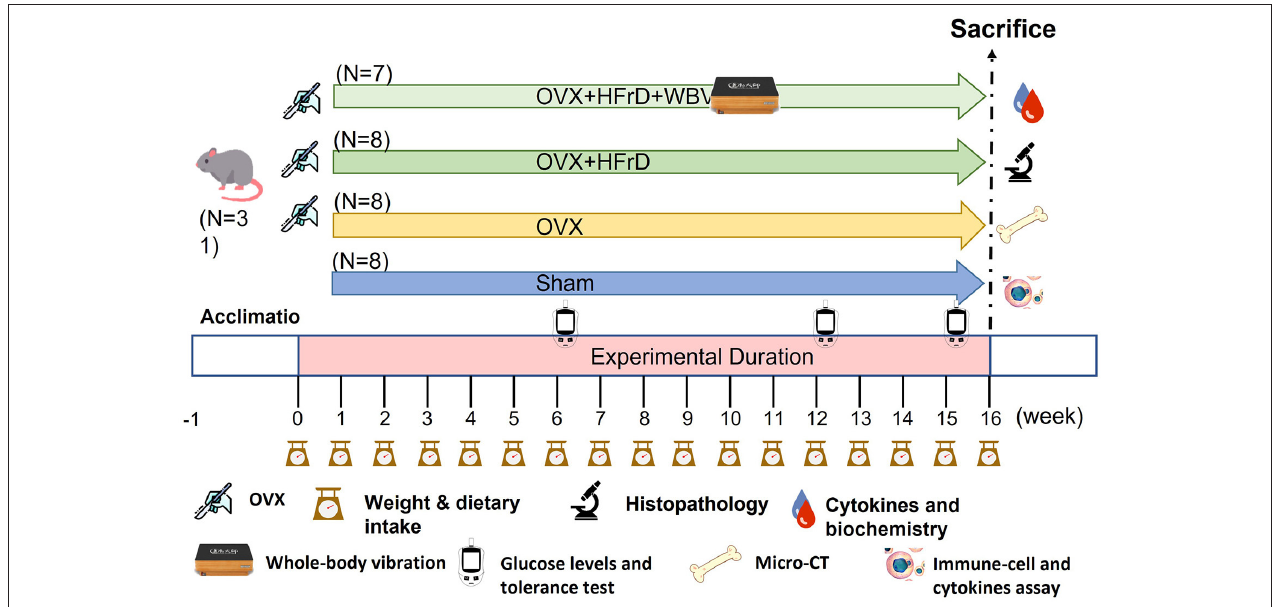
FIGURE 1 | Experimental design to test for the effects of whole-body vibration (WBV) exercise on the ovariectomized (OVX) mouse model combined with a high-fructose diet (HFrD). The animals were randomly assigned to one of four groups (sham, OVX, OVX + HFrD, and OVX + HFrD + WBV) with animals undergoing ovariectomy (OVX), high-fructose diet (HFrD), and whole-body vibration exercise (WBV) interventions as indicated. The WBV intervention was implemented using the following parameters: 13Hz, 0.68g, 30 min/session, 2 sessions/d 4h apart, for 5 d/week. The diet and exercise interventions were administered for 16 weeks. Dietary intake, body weight, and glucose levels were monitored during the experiment and the cytokines, immune cells, histopathology, biochemistry, and micro-CT evaluations were conducted immediately after